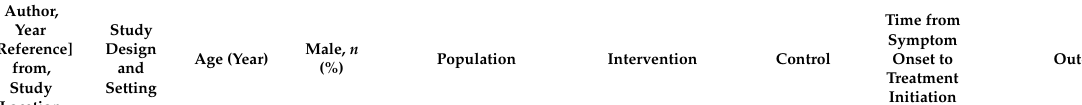
Table 1. Data extracted from included papers ( n =